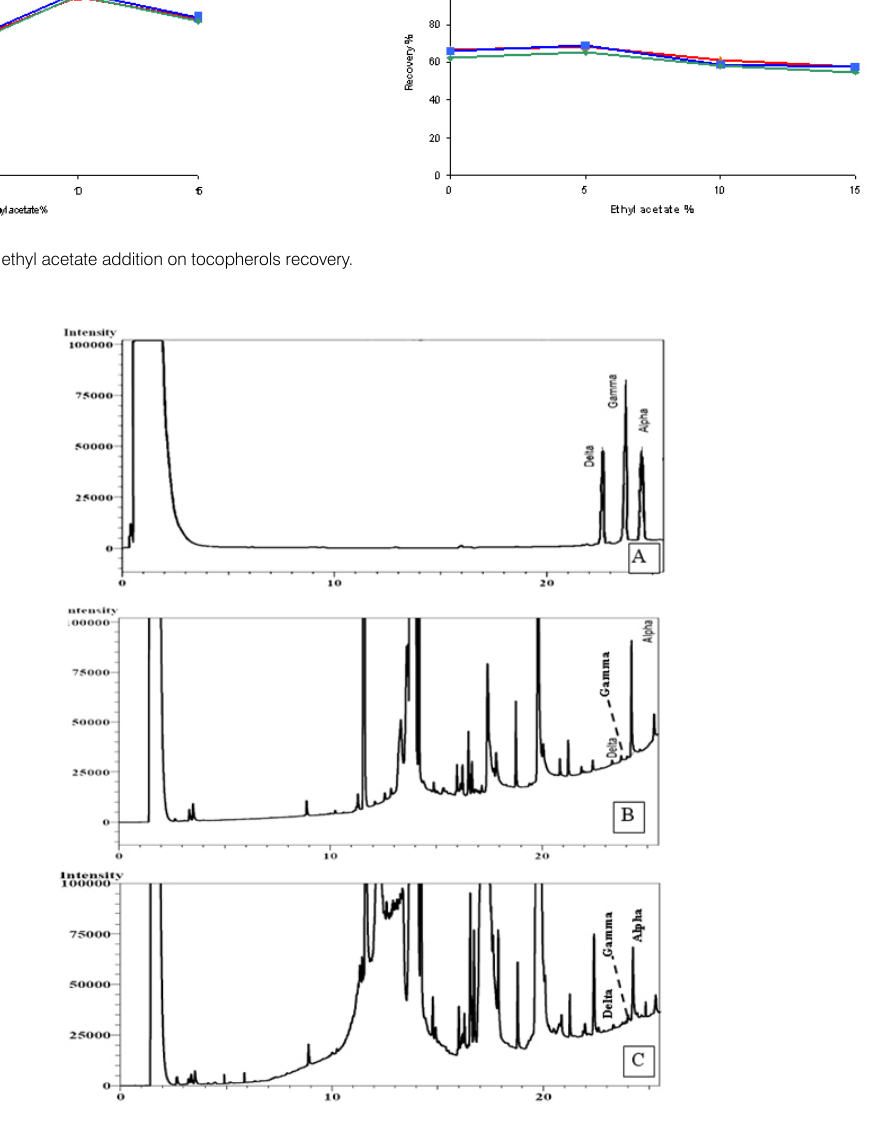
Figure 2. The chromatograms of tocopherols standards (A) and sunflower oil extract obtained by SPE with Porapak Q (B) and liquid-liquid extraction